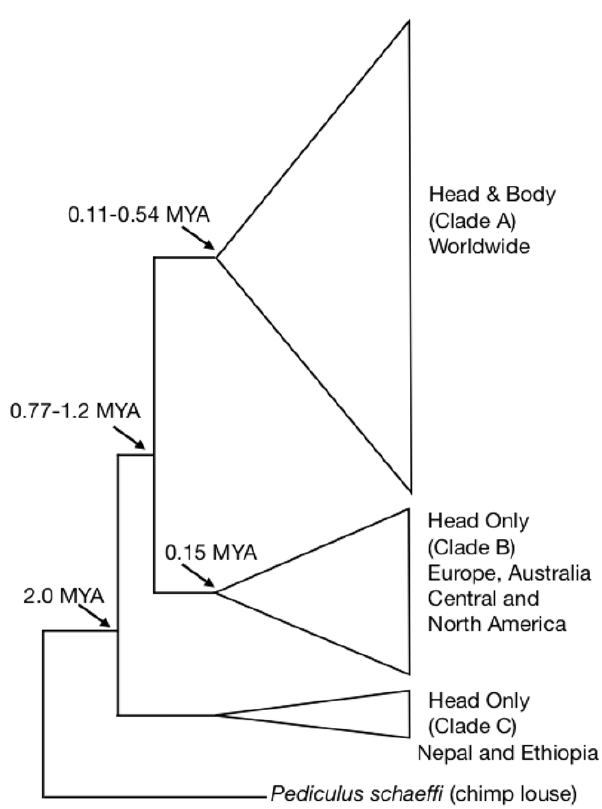
Figure 1. Phylogenetic relationships, timing of divergence events (in millions of years; MYA) and geographic distribution among human lice based on the mitochondrial COX1 gene [ 7,27,28 ] . Height of the triangles represents the number of specimens in each clade. Figure modified from [29].